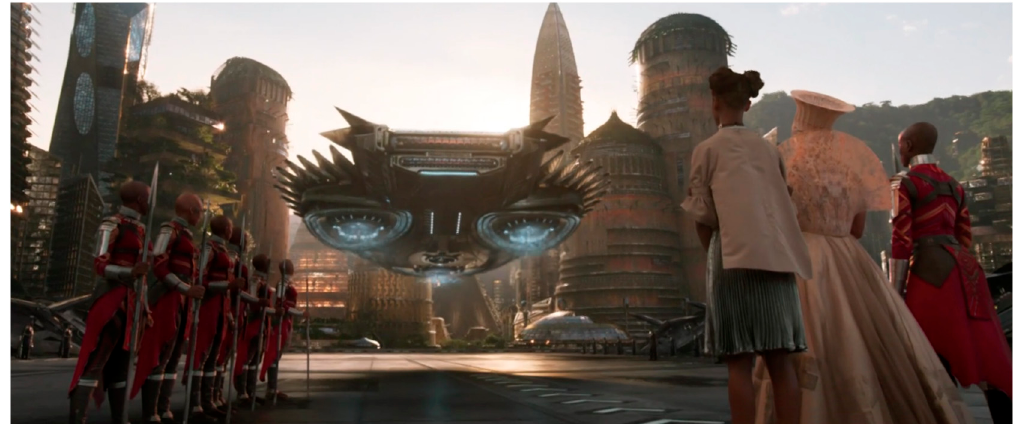
Figure 5. Women of Wakanda – soldiers, Shuri and the Queen as T’Challa lands in Wakanda (Taken in accordance with fair use of images rights for the film Black Panther, Ryan Coogler, 2018, Marvel).